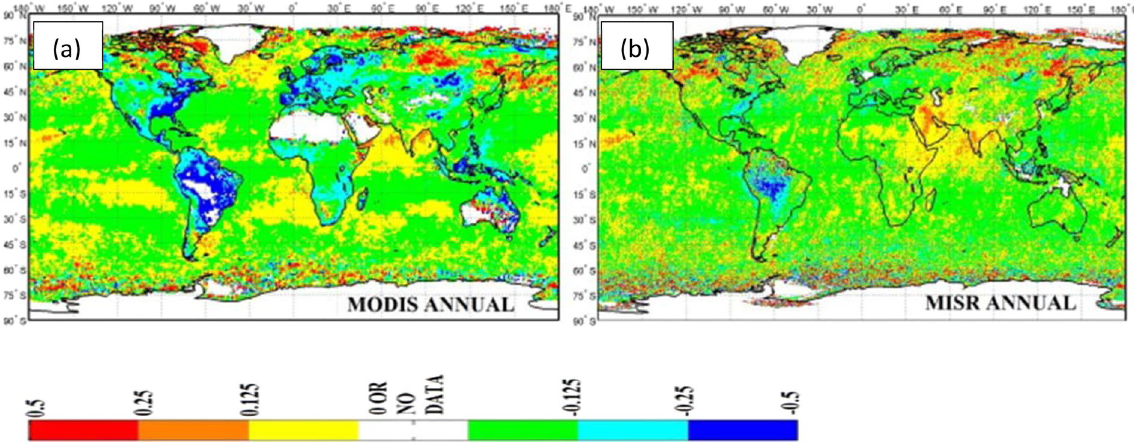
Figure 7. Annual global relative changes in AOD (%). Depictions are from ( a ) MODIS (1 by 1 degree) data and ( b ) MISR (0.5 by 0.5 degree) data. Percent change is based on average AOD for the period 2008–14 minus average AOD for the period 2001–07 15